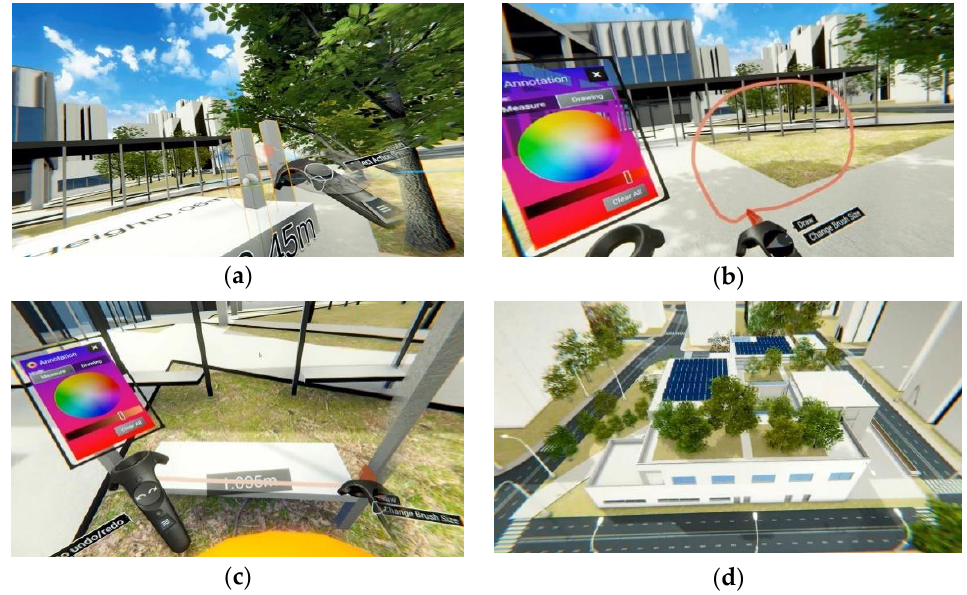
Figure 2. Interactive functions of the system: ( a ) primitive creation, ( b ) annotation, ( c ) measurement, and ( d ) scale-model mode.